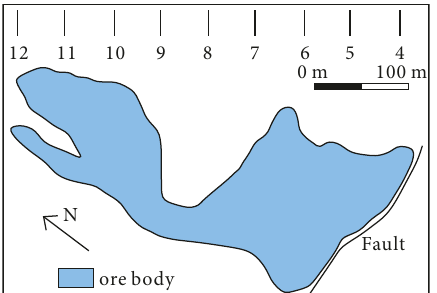
Figure 1: The plane projection map of the 1 # ore body at the 1650m level.